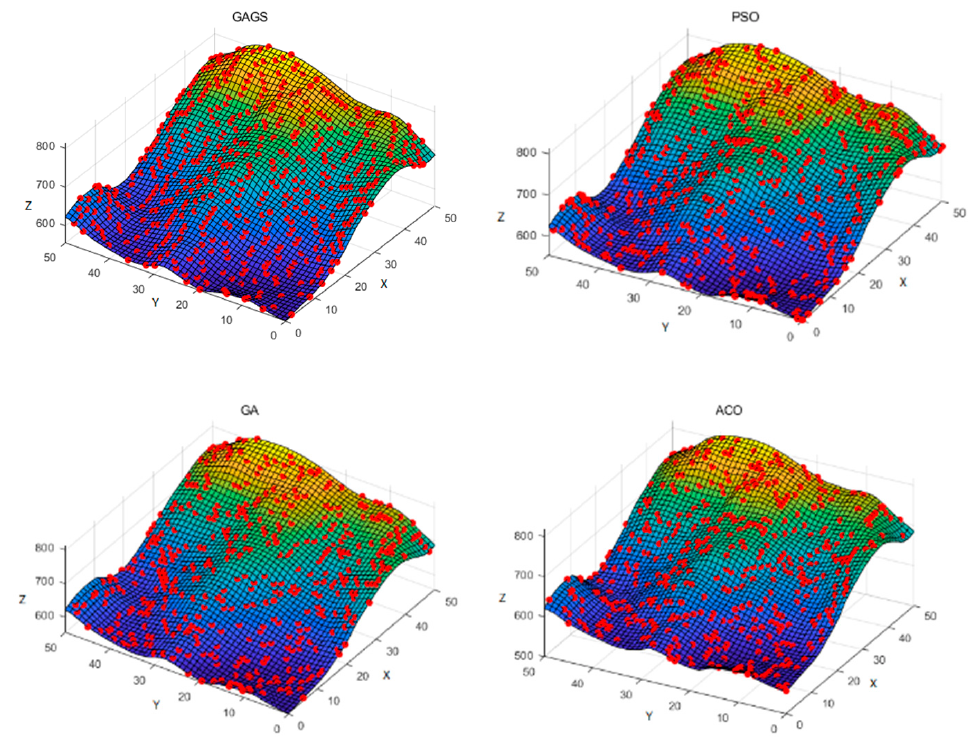
Figure 7. Node deployment under simple terrain model.